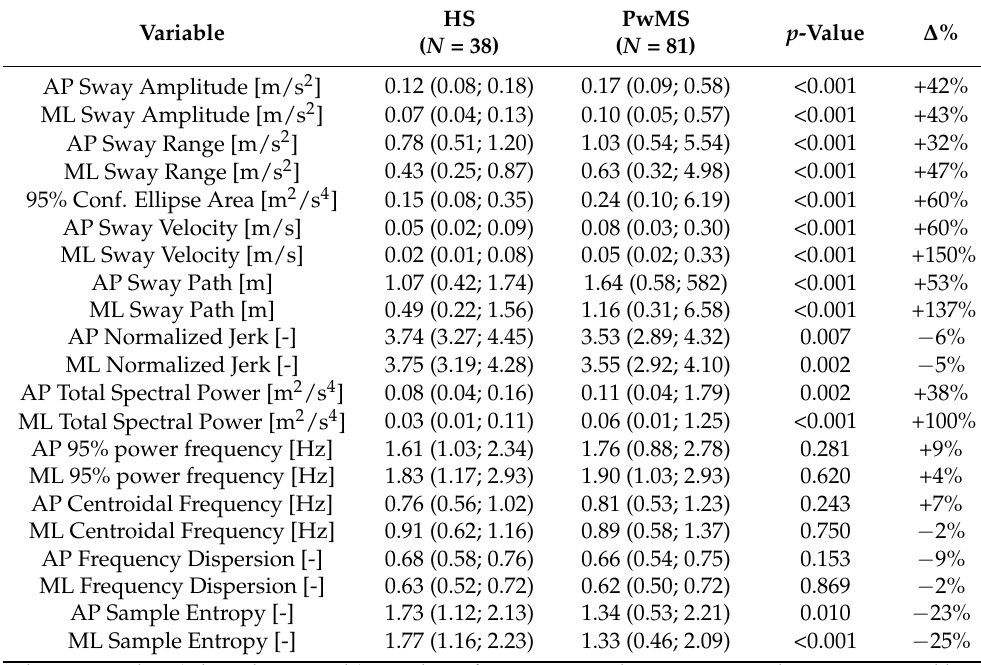
Table 3. Wearable-sensor-based variables were computed during the instrumented modified Romberg test (ImRomberg) executed by healthy subjects (HS) and people with multiple sclerosis (PwMS).